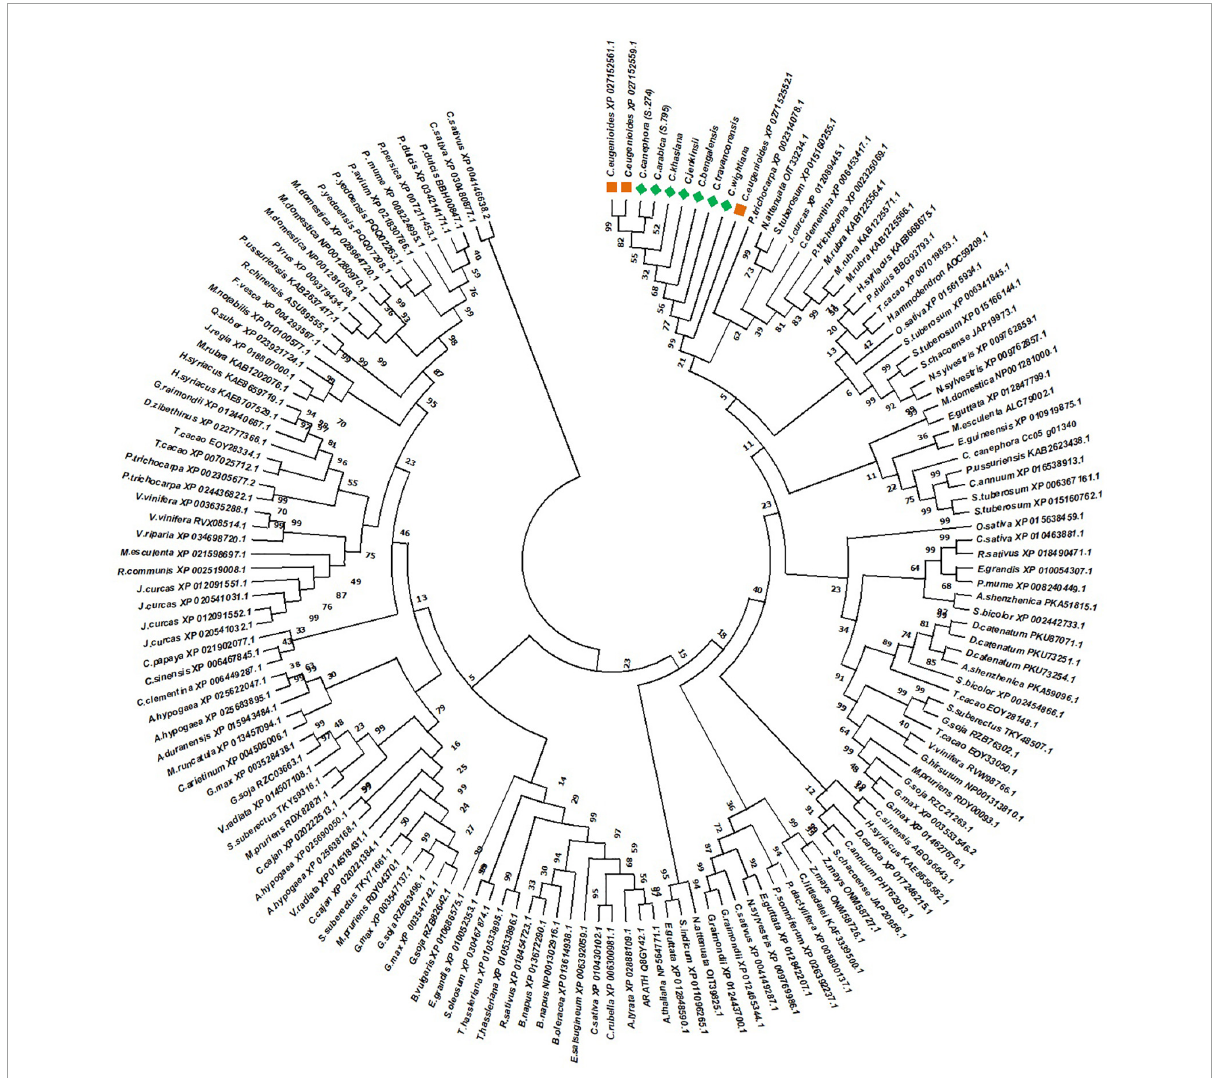
FIGURE4 Phylogenetic tree constructed by using 147 NAC25 protein sequences belonging to 72 different crop species along with NAC25 protein sequences of C. eugenioides (orange squares) and NAC protein sequences isolated in the present study (green square) by Maximum Likelihood approach Jones-Taylor-Thornton (JTT)